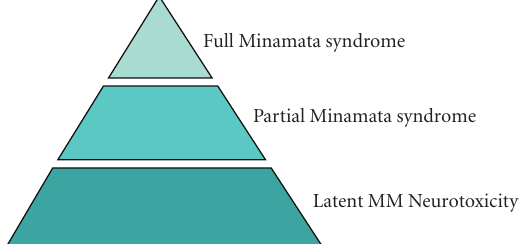
Figure 4: Schematic of scope of neurotoxic signs stemming from exposure to methylmercury. The full syndrome, as in Table 3, occurs with massive exposures. The primary current question, a population question, arises from the possible occurrence of subtle neuropsychological deficits that would only be evident with systematic testing; that is, latent e ff ects.